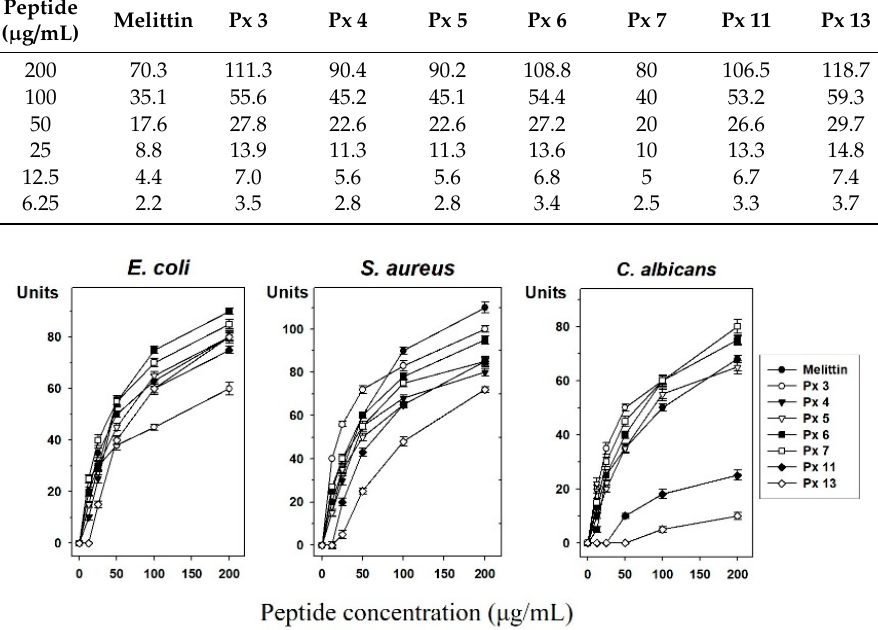
Table 2. Molar concentrations ( μ M) for the antimicrobial and hemolytic activities of peptides. Peptide Melittin Px 3 ( μ g/mL)